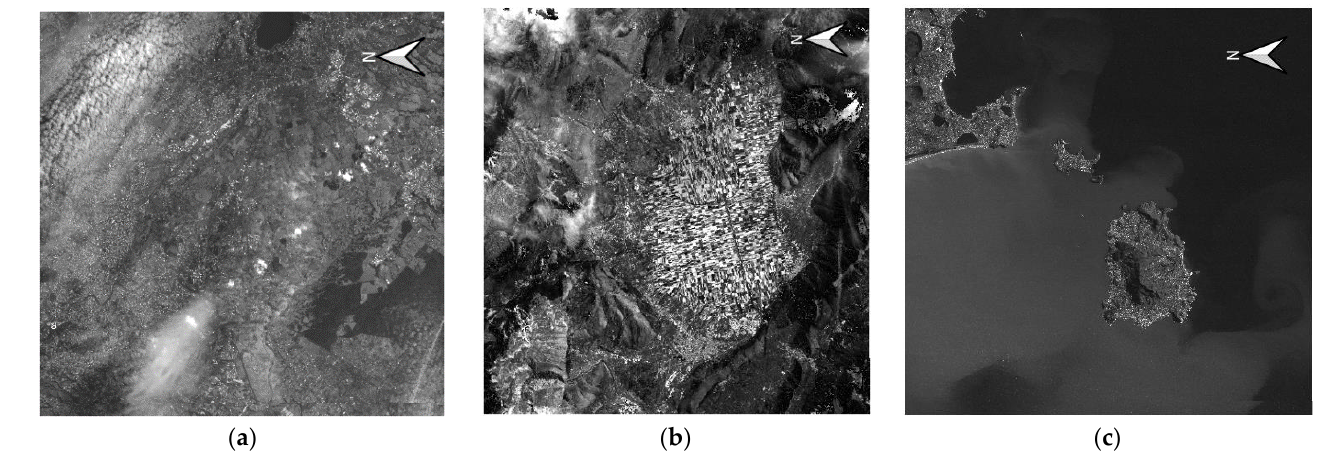
Figure 2. Correct export of the panchromatic product, test field of Rome ( a ), Fucino ( b ) and Ischia ( c ).